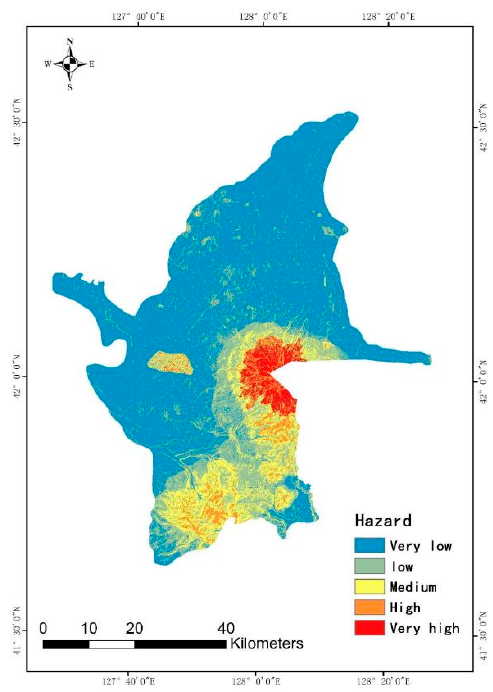
Figure 7. Earthquake-induced landslide hazard map.